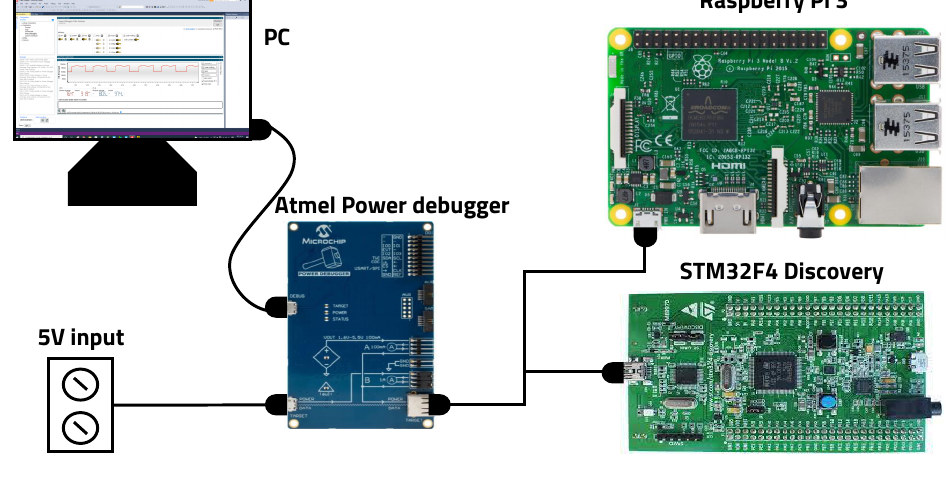
Figure 13. Experimental